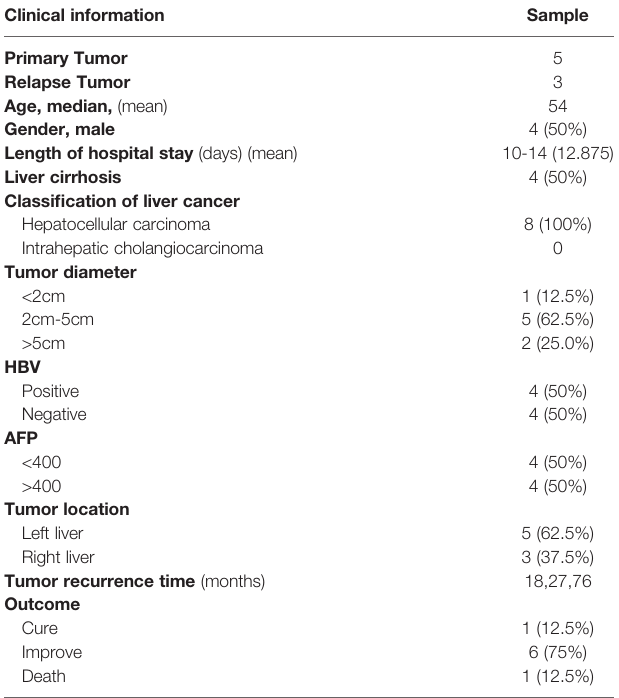
TABLE 1 | Clinical sample information.